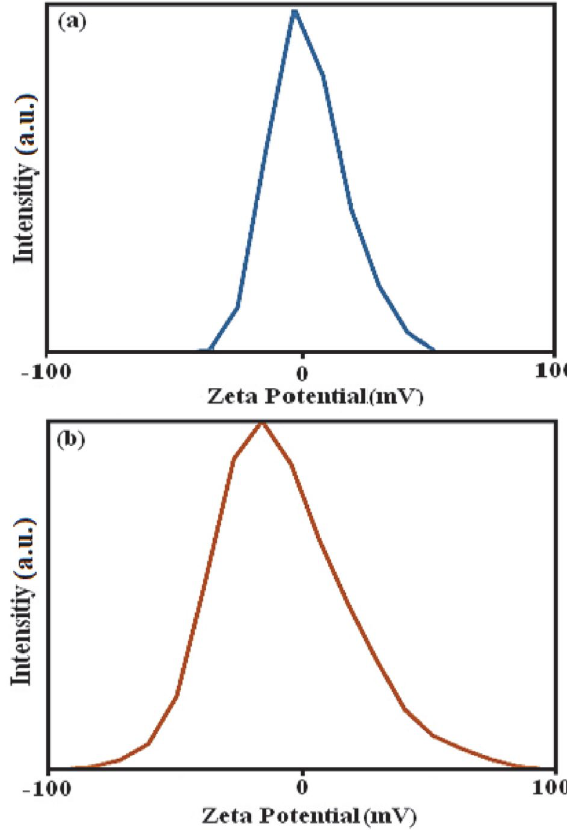
Figure 7. Zeta potential distribution curves of (a) pristine MIL-101 and (b) P 5 W 30 /MIL-101 (Cr) hybrid in aqueous solutions